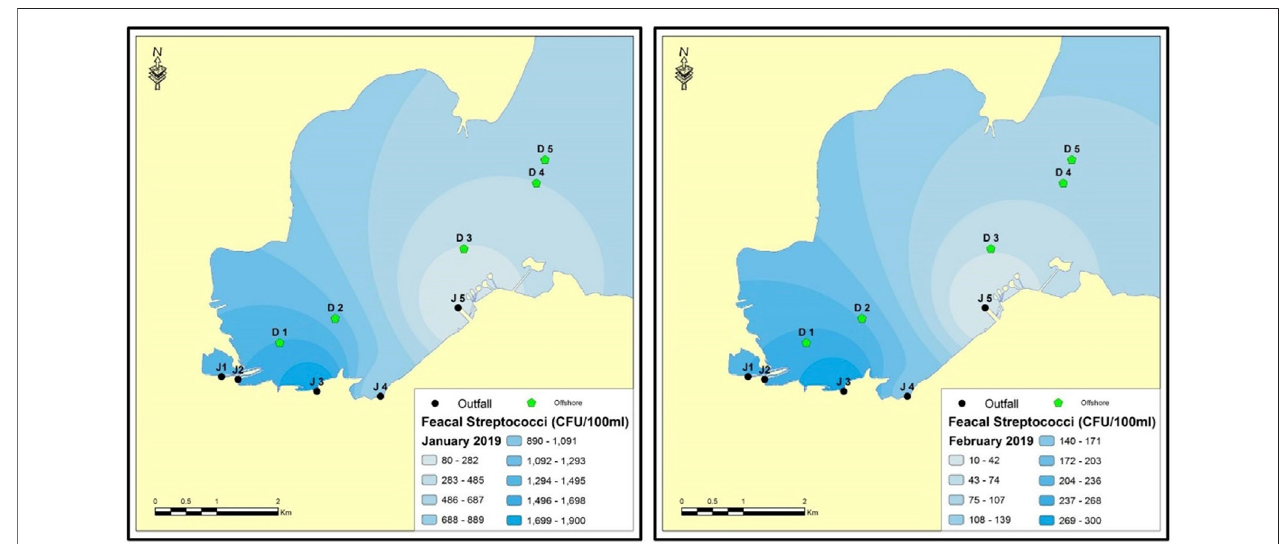
FIGURE 8 | Distribution of fecal Streptococci in Doha Bay using